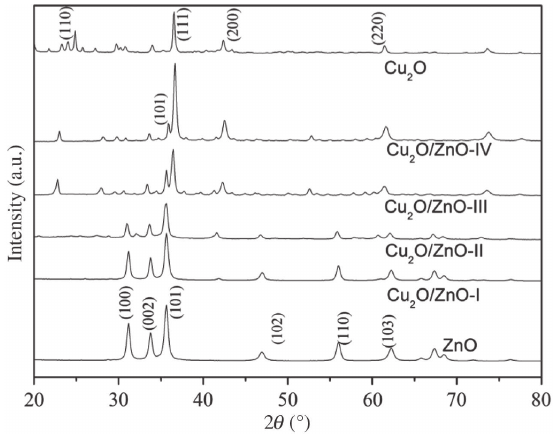
Figure 1: XRD patterns of Cu 2 O/ZnO prepared with different Cu 2 O